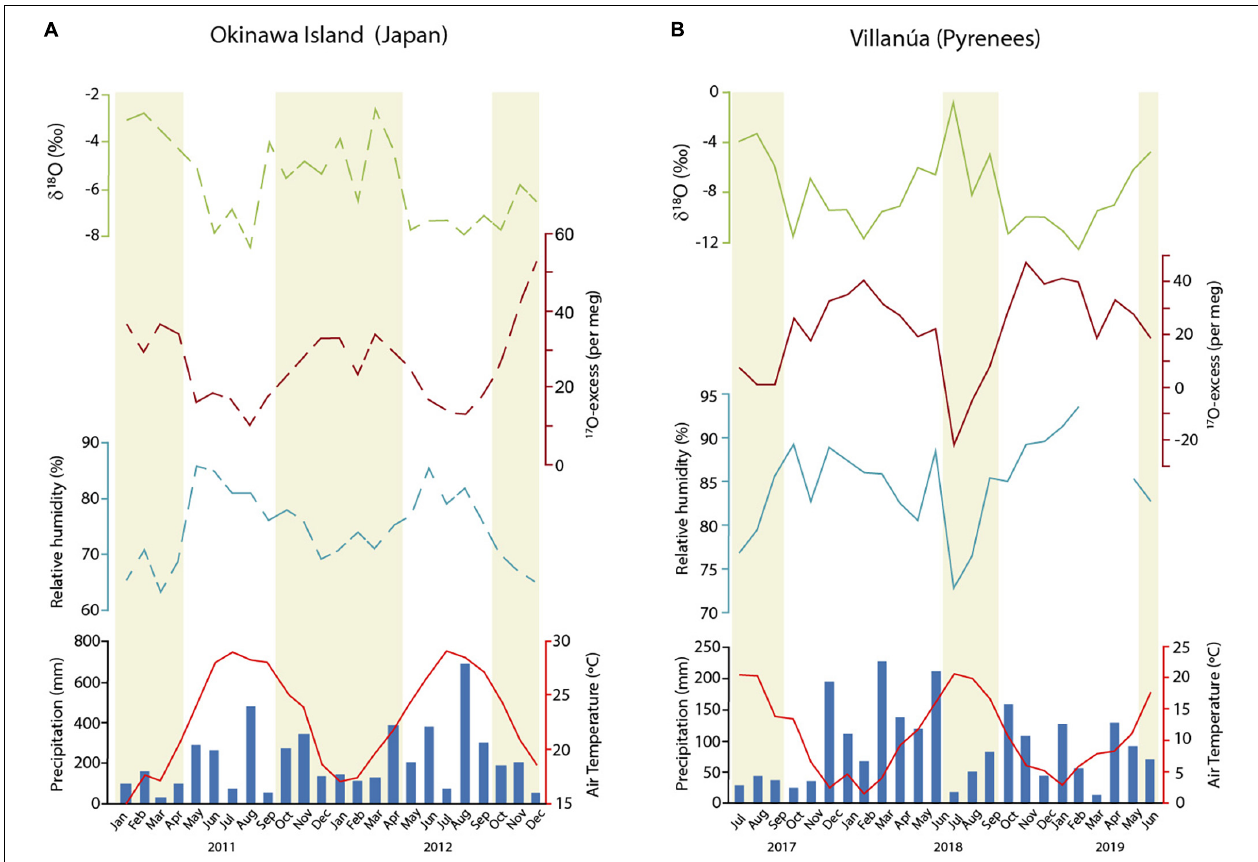
FIGURE 6 | Temporal variation of monthly precipitation-weighted average values of δ 18 O and 17 O-excess and meteorological data (monthly RH, monthly precipitation amount, and monthly mean air temperature) (A) at Okinawa Island (modified from Uechi and Uemura, 2019) and (B) at Villanúa (average RH of the rainfall events for every month). Shaded areas indicate time periods of low